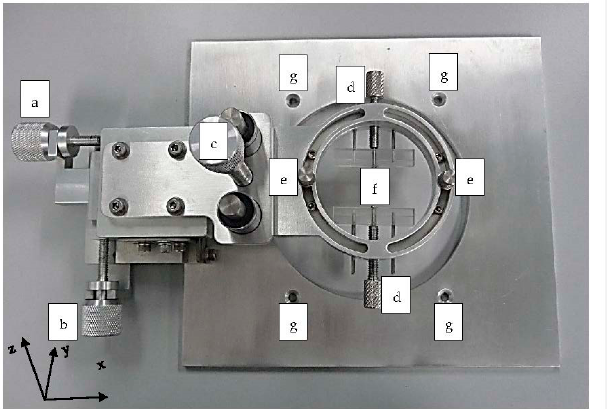
Figure 7. Image of the portable polydimethylsiloxane (PDMS) aligner with its functional knots that allow the PDMS layer to be moved in micro-meter ( μ m) intervals along the x , y , and z directions. (Labels: a. Left-right knot for PDMS slab’s left-right adjustment along the x -coordinates; b. Up-down knot to move PDMS slab’s up and down with micrometer intervals along the y -coordinates; c. Top-bottom knot to lower down the top layer of PDMS slab towards the bottom layer of PDMS slab along the z -coordinates and finally seal them together; d. PDMS-clip tightened knot for PDMS clip’s position adjustment; e. Skew adjustment knot to rotate PDMS slab in the x - z plane; f. PDMS clip to secure the position of the PDMS slab; and g. Screw hole to temporarily secure the device on the microscopic stage).